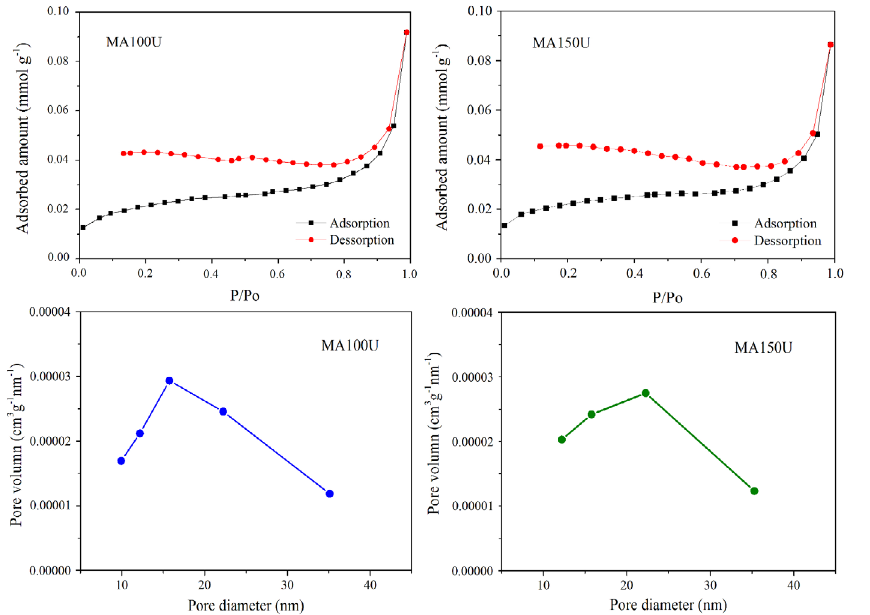
Figure 4. Nitrogen adsorption and desorption isotherms and pore size distribution of the MA100U and MA150U samples.